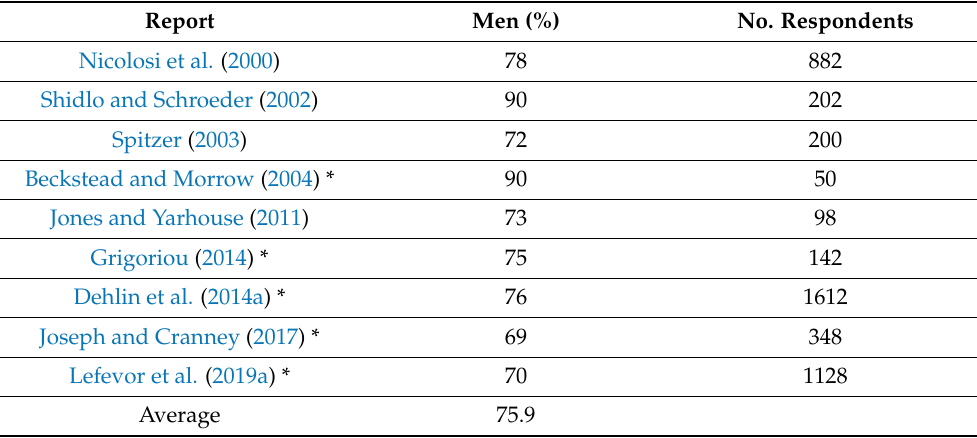
Table 7. Only about 25% Of Respondents in Studies Using Convenience Sampling Are Female.